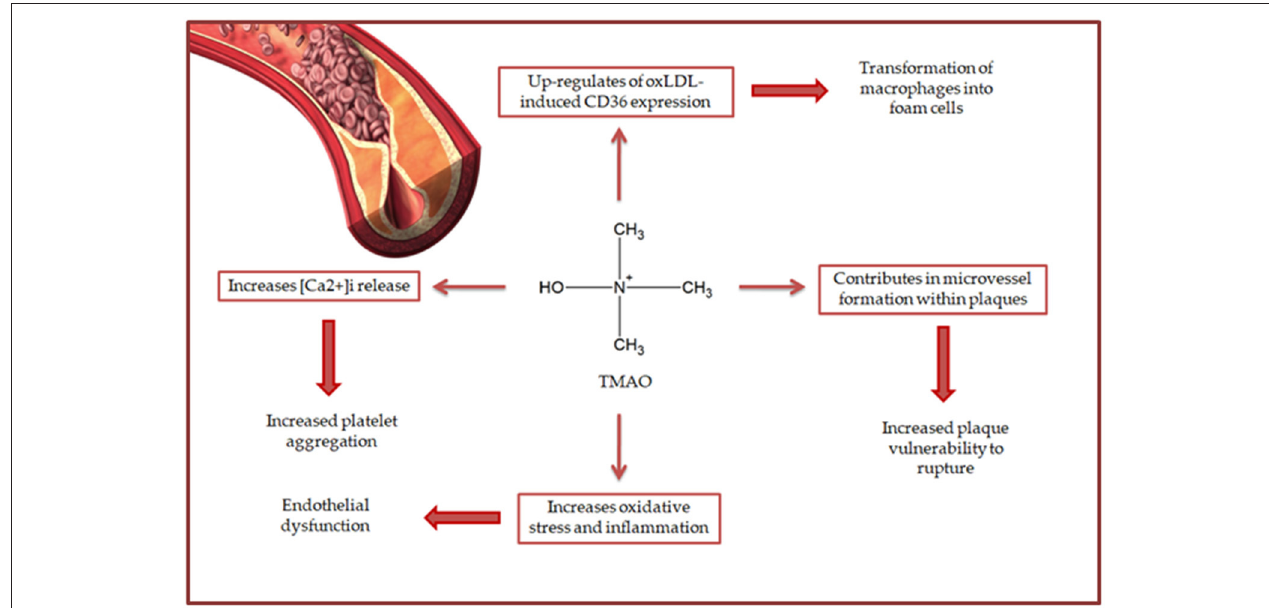
FIGURE 4 | The role of TMAO in atherosclerosis development and